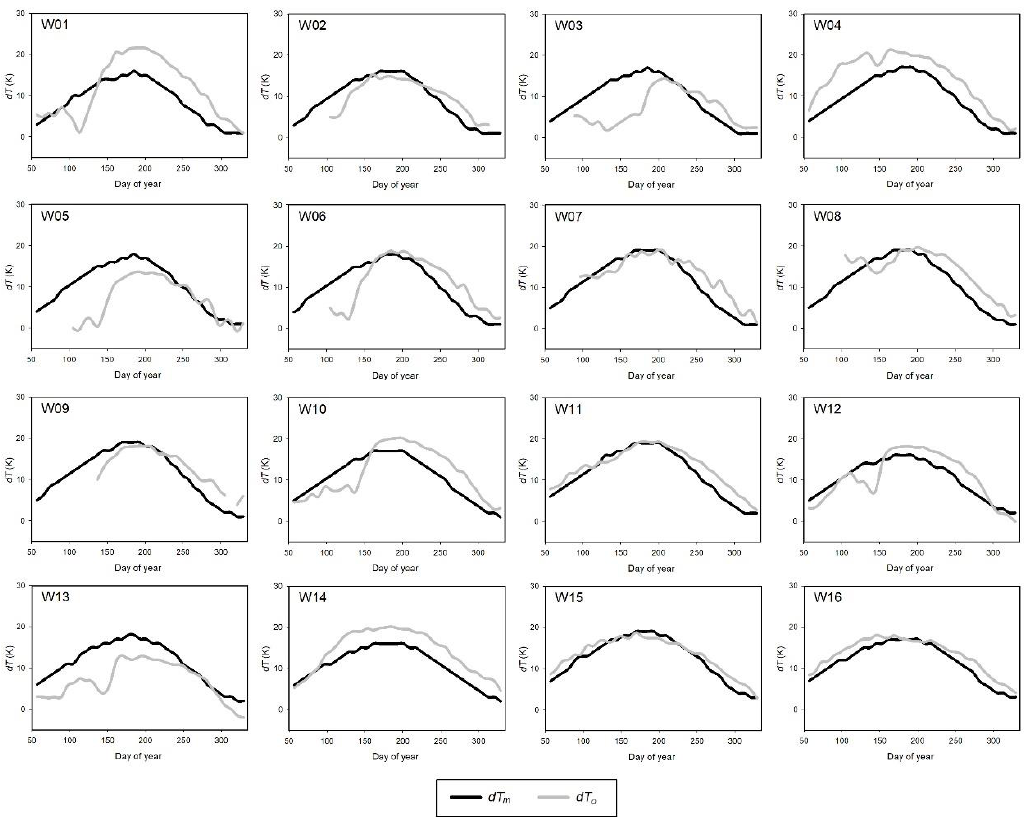
Figure 4. Timeseries plots of dT o and dT ( dT m ) for the sample blocks in the West Coast region. The label in each plot indicates the name of the sampling block shown in Figure 3.